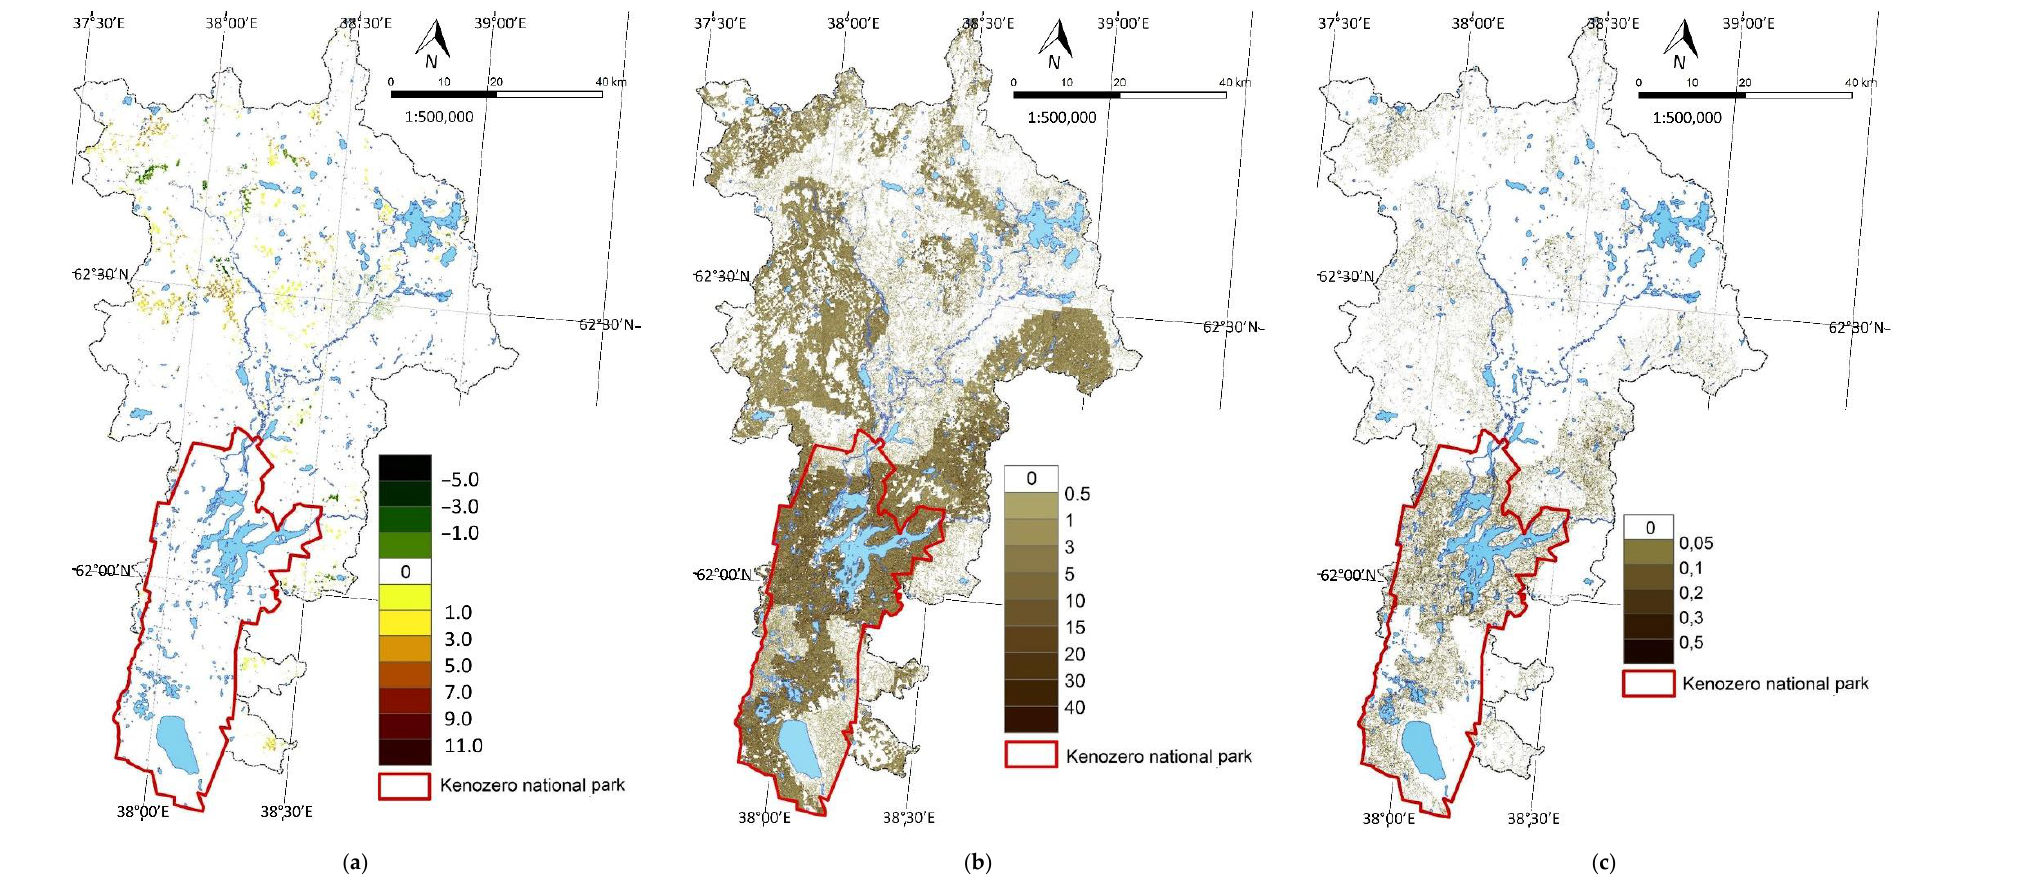
Figure 8. Erosion changes due to forest felling: ( a ) changes in erosion between 2007 and 2021 (t/ha/year); ( b ) changes after hypothetical case of total forest felling, compared to 2021 (t/ha/year); ( c ) changes in erosion few years after total forest felling, compared to 2021 (t/ha/year).